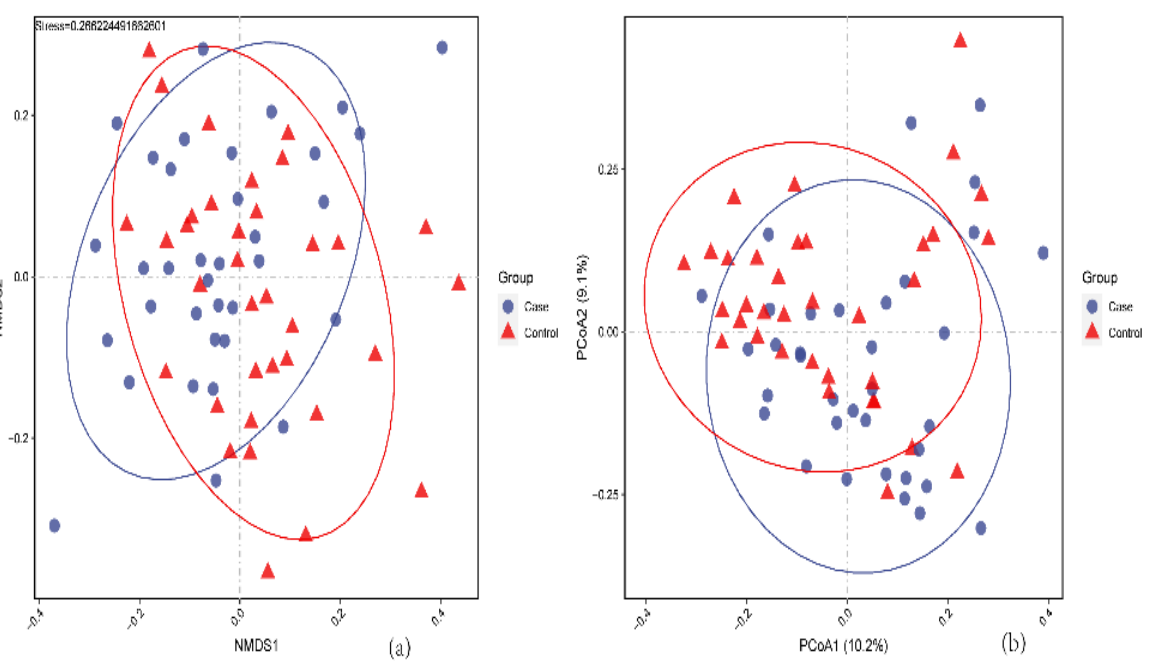
Figure 2. The beta diversity of PIH and healthy controls. ( a ) NMDS analysis in two groups. ( b ) PCoA analysis in two